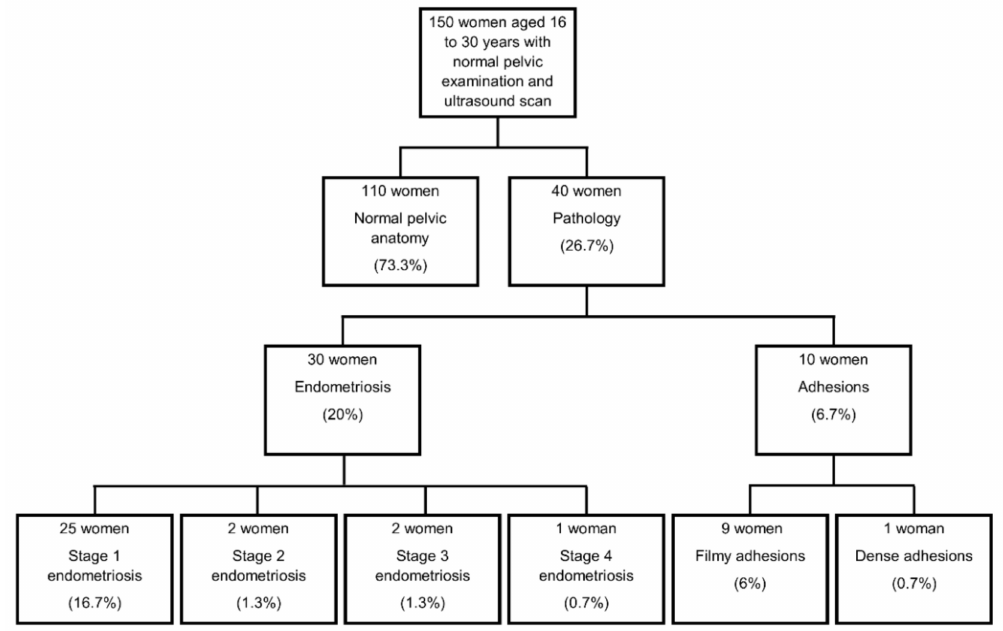
Figure 1. Flow chart of laparoscopy